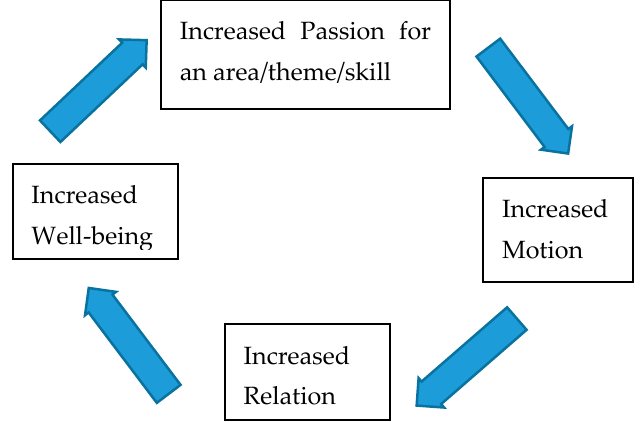
Figure 1. Passion, motion, relation, well-being circle.